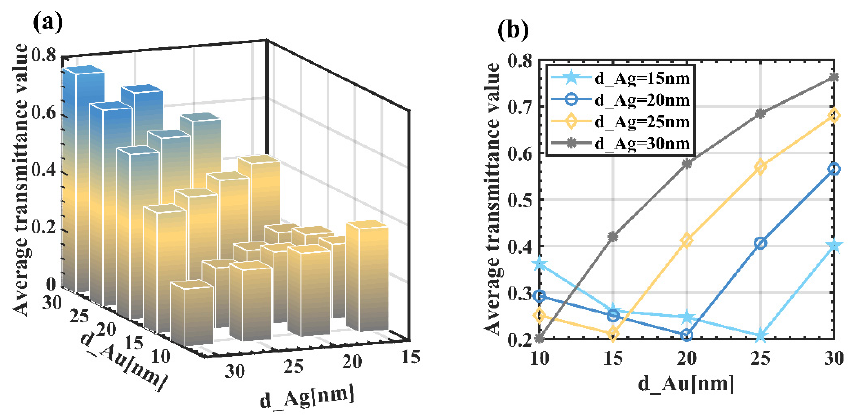
Figure 5. Average value of minimum transmittance under different metal layers.